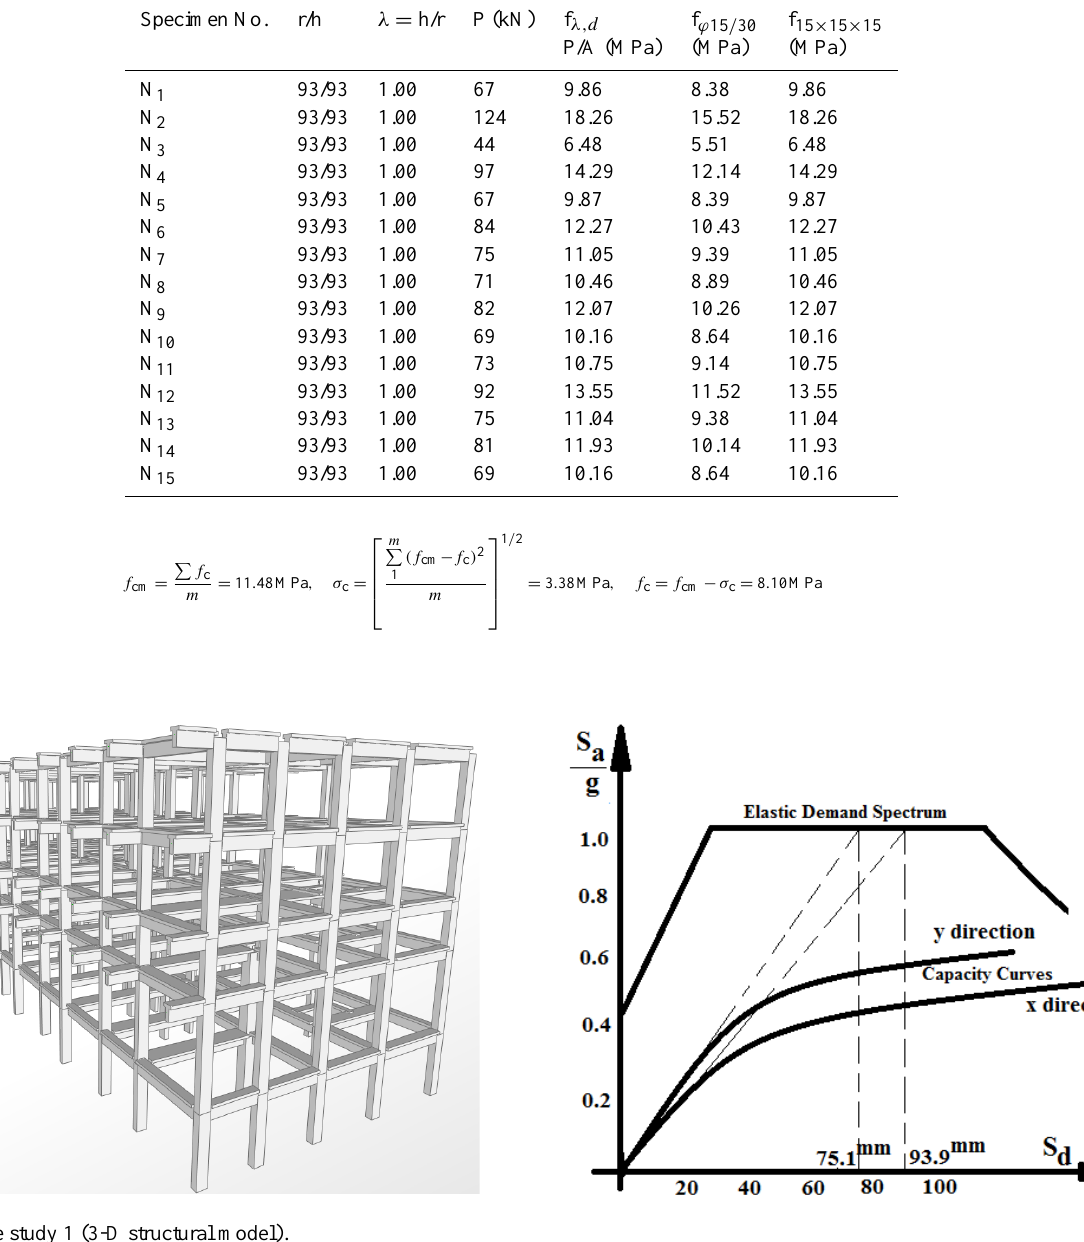
Fig. 15. Capacity curves at x and y directions for case study 1.